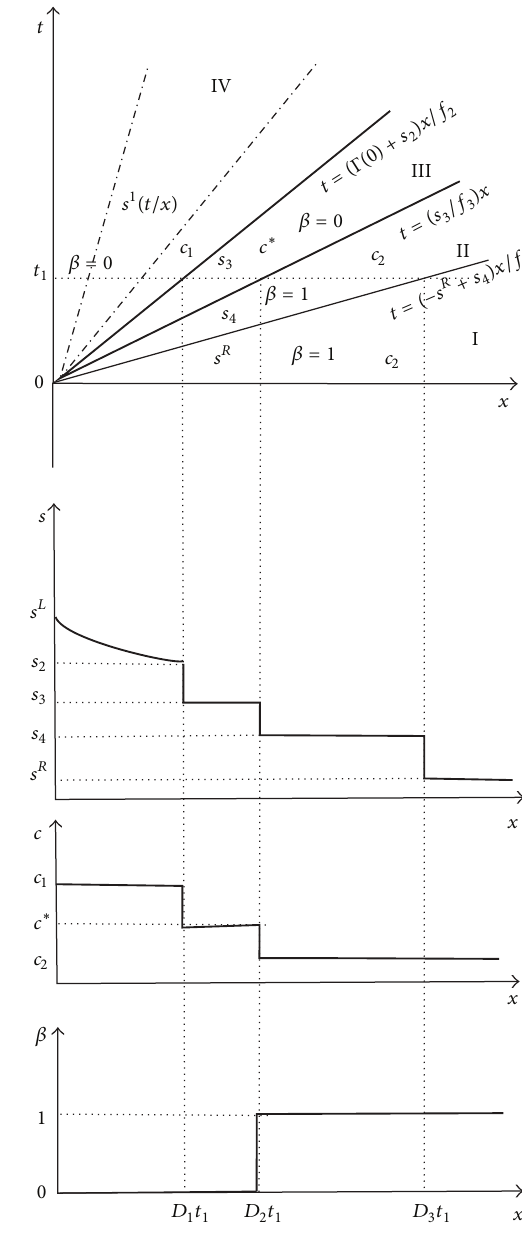
Figure 10: Solution of the Riemann problem: (a) trajectories of shock fronts and characteristic lines in (𝑥, 𝑡) -plane; (b) saturation profile; (c) chemical concentration profile; (d) salinity